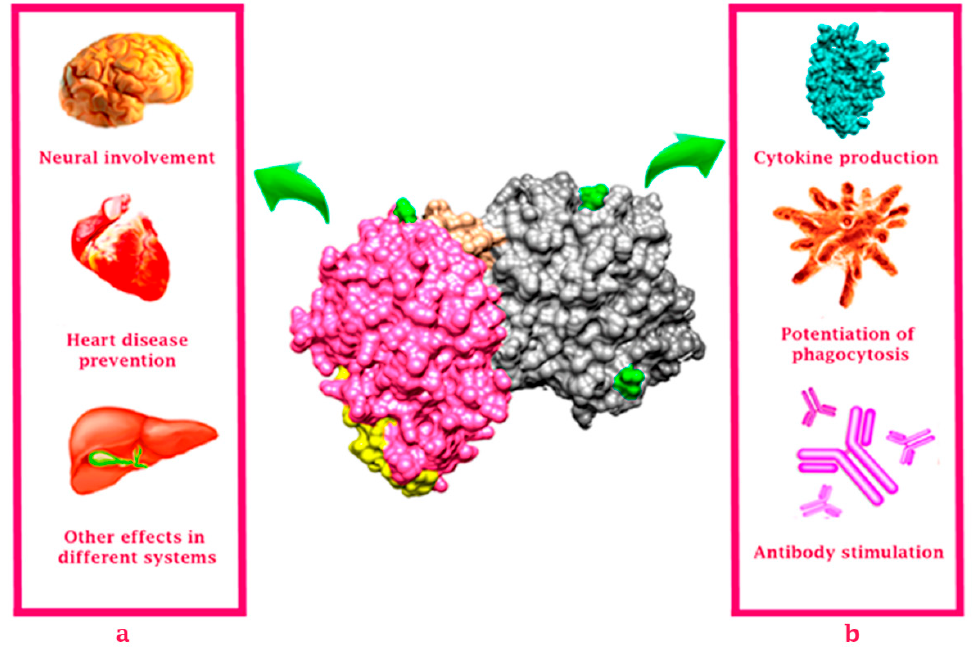
Figure 2. Schematic representation of the effects of lactoferrin in the body. ( a ) Non-dependent pathogenesis of Lf activities; Lf has implications on neurodevelopment and some neurodegenerative injuries and may be involved in the prevention of heart disease due to its effect on levels of lipoprotein accumulation. It can exert effects on metabolic activity in different systems. ( b ) Dependent pathogenesis of Lf activities; Lf can promote cytokine production, enhance phagocytosis and stimulate antibody production and various signaling pathways, in response to diverse diseases such as infection or cancer. Possible glycosylation sites are shown in green (Asn-138, Asn-479 and Asn-624), and the lactoferricin peptide is shown in yellow (amino acids 17–41). The N-terminal lobe (amino acids 1–332) is shown in pink and the C-terminal lobe (amino acids 344–703) is shown in gray.